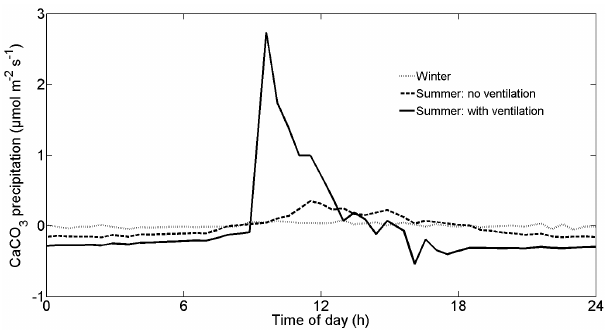
Fig. 2. Diel patterns of carbonate weathering. Figure 2 shows the diurnal pattern of calcium carbonate precipitation (positive, CO 2 production) and dissolution (negative, CO 2 consumption) for three different scenario’s using the WITCH model. The dotted line shows a typical day in the wet season (winter), when geochemical fluxes are close to zero and thus of marginal importance compared to bio- logical fluxes. The dashed line shows a typical day in the dry season when ventilation was not included in the model. Geochemical fluxes are now slightly larger than in the wet season, due to a larger rela- tive difference in soil water content (SWC) between night and day. The solid line shows the same day in the dry season, but here ven- tilation was included in the model. Calcium carbonate precipitation and dissolution are now strongly enhanced by